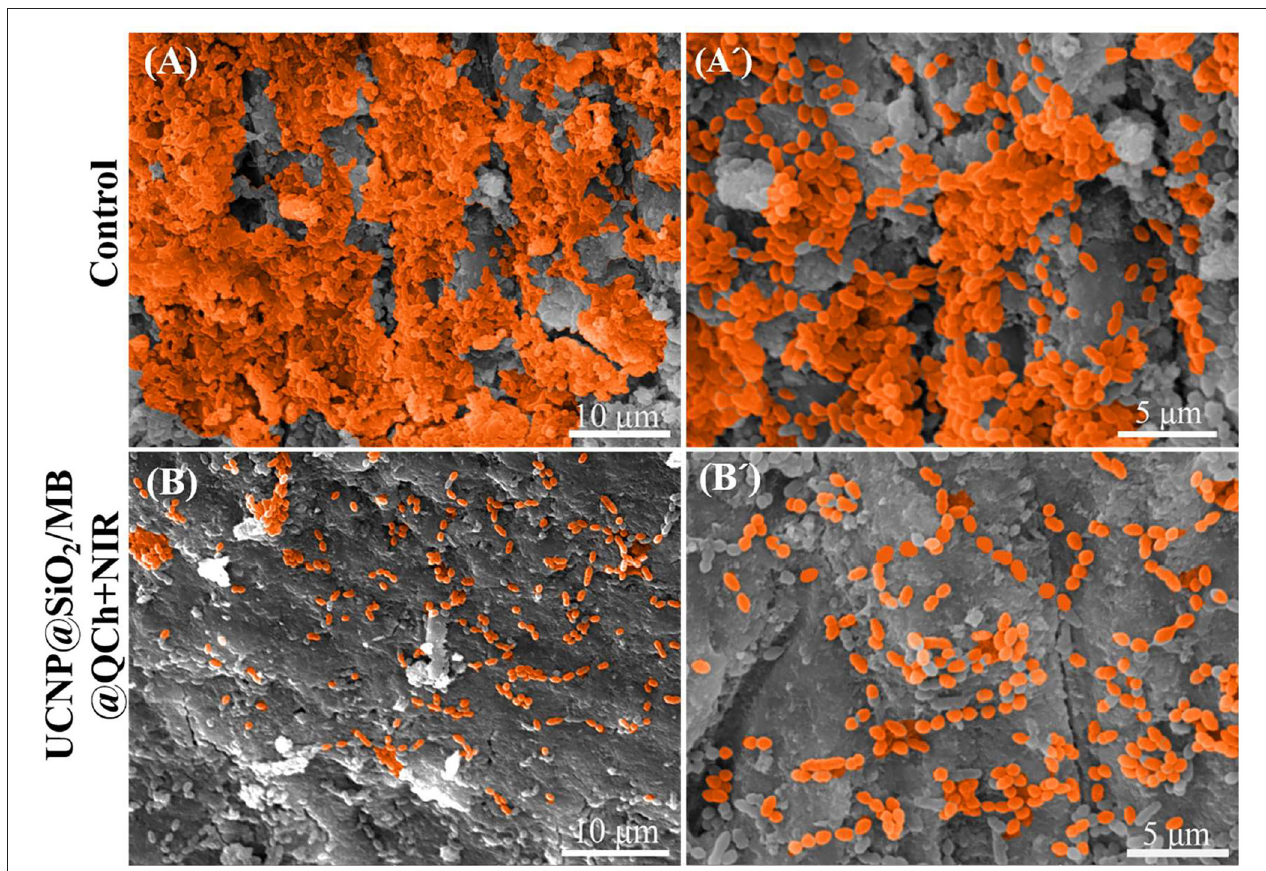
FIGURE 7 | SEM images of E. faecalis (A,A’) without and (B,B’) with the treatment of UCNP@SiO 2 /MB@QCh.